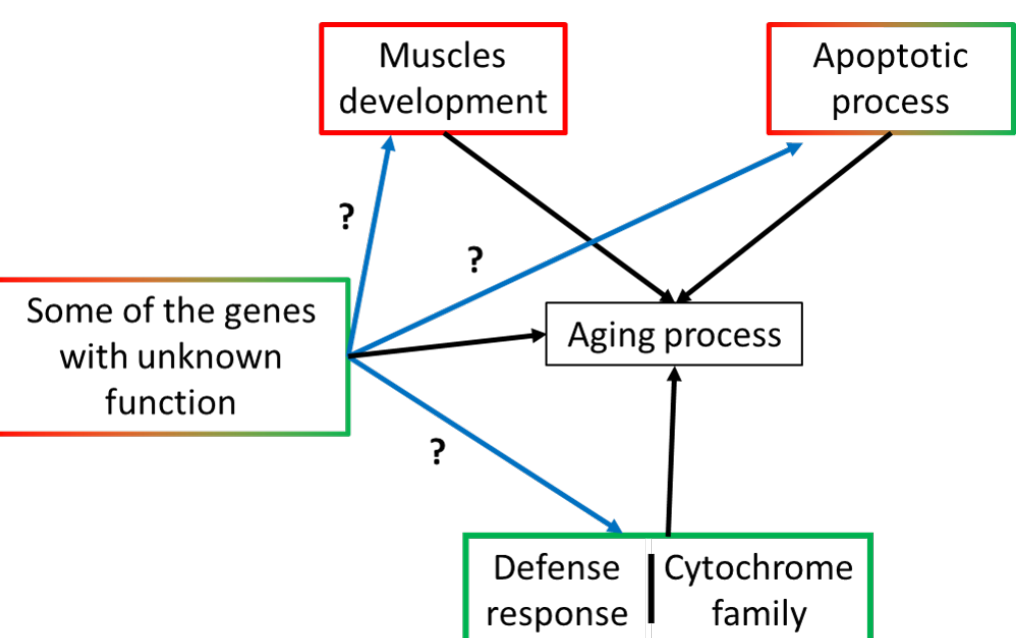
Figure 6. Overview of the processes that are affected during aging process. Processes contoured in red are mainly downregulated during aging while processes contoured in green are mainly upregulated during aging. Among the 12 genes tested the knockdown of five decreased longevity, whereas their expression level increased during aging. Conversely, the knockdown of one increased longevity, whereas its expression level decreased during aging. Black arrows represent known interaction while blue arrows represent potential interaction.